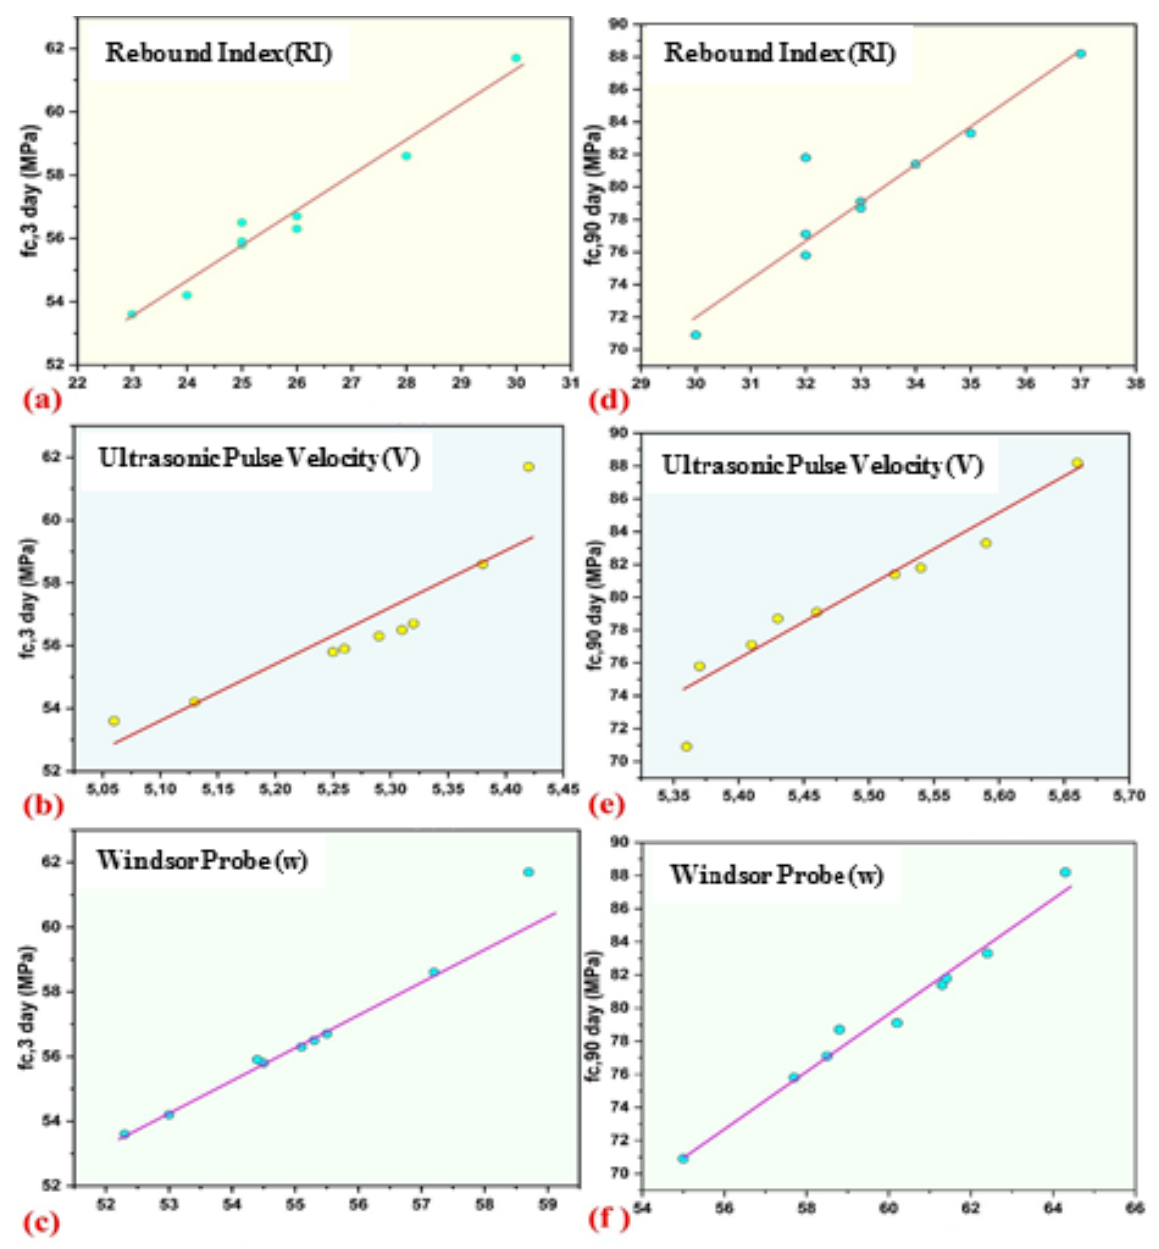
Figure 4. Relationship between non-destructive test method results and compressive strength. Figure 4b,e show the relationship between ultrasonic pulse velocity ( V ) test results on strength. In this test method, the transition rate was obtained by dividing the length transition time shortened, and V increased. The test result measurements obtained